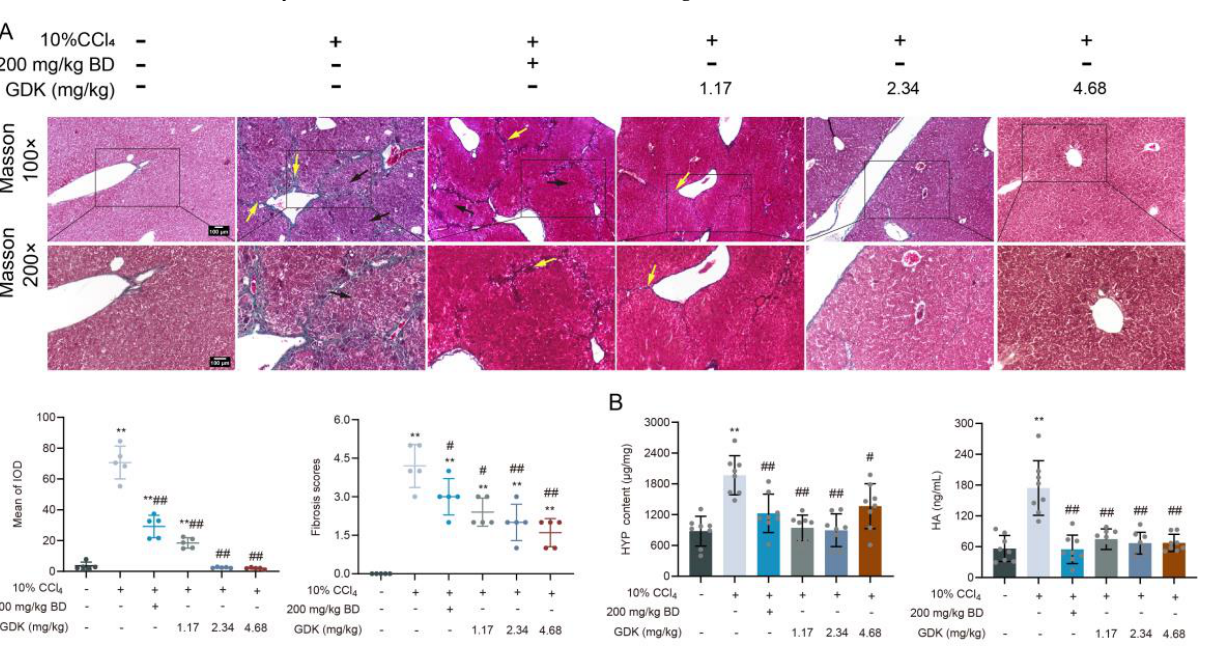
Figure 4. GDK suppresses fibrosis in CCl 4 -induced chronic liver injury mice. ( A ) Masson’s staining of liver sections and quantitative result in indicated mice. Scar bar, 100 µ m. Black arrow: Pseudolobule; Yellow arrow: Fibrosis. ( B ) Serum HYP and liver HA levels in indicated mice (n = 8 samples per group). * p < 0.05, ** p < 0.01, # p < 0.05, and ## p < 0.01.